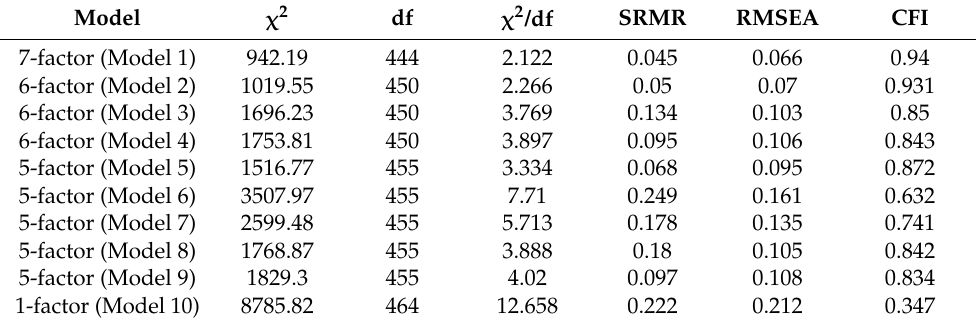
Table 1. Results of confirmatory factor analysis.